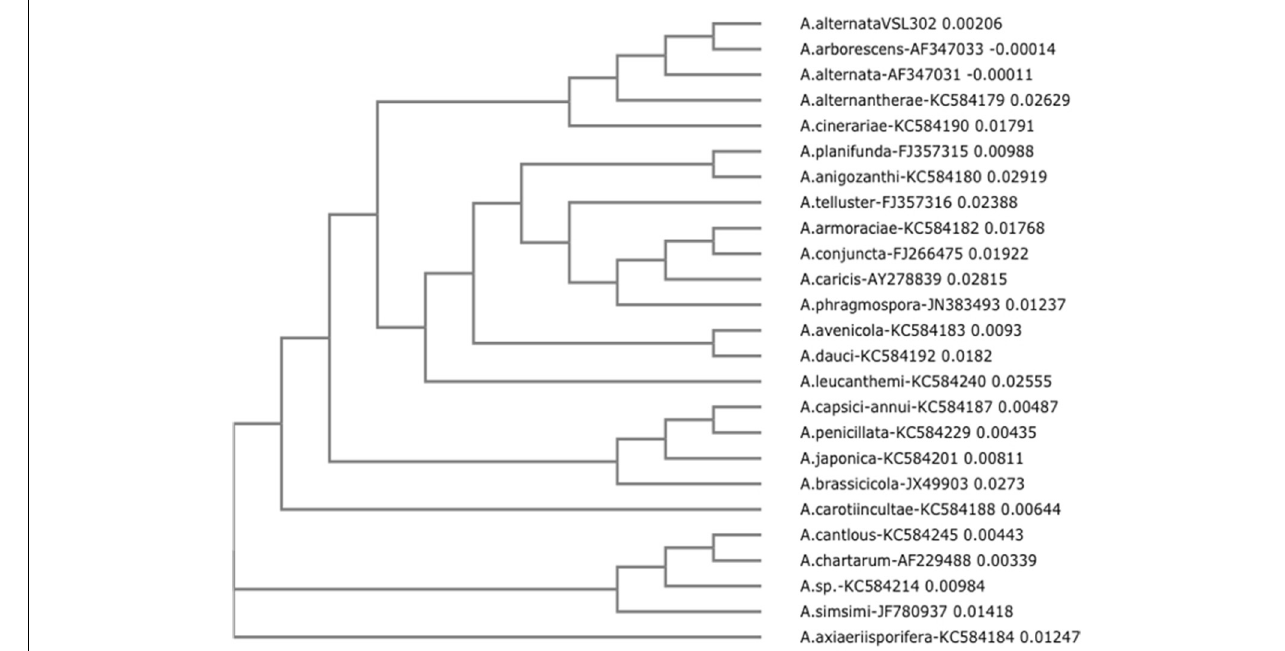
FIGURE 1 | Neighbor-joining (NJ) tree of ITS1-5.8s-ITS2 from Alternaria alternata VSL302. ThetreeisbasedonITS1-5.8s-ITS2sequencesof24strains of Alternaria . Each strain correspond to a taxonomic section of the genus Alternaria . It is observed that A. alternata VSL302 grouped with the strains that